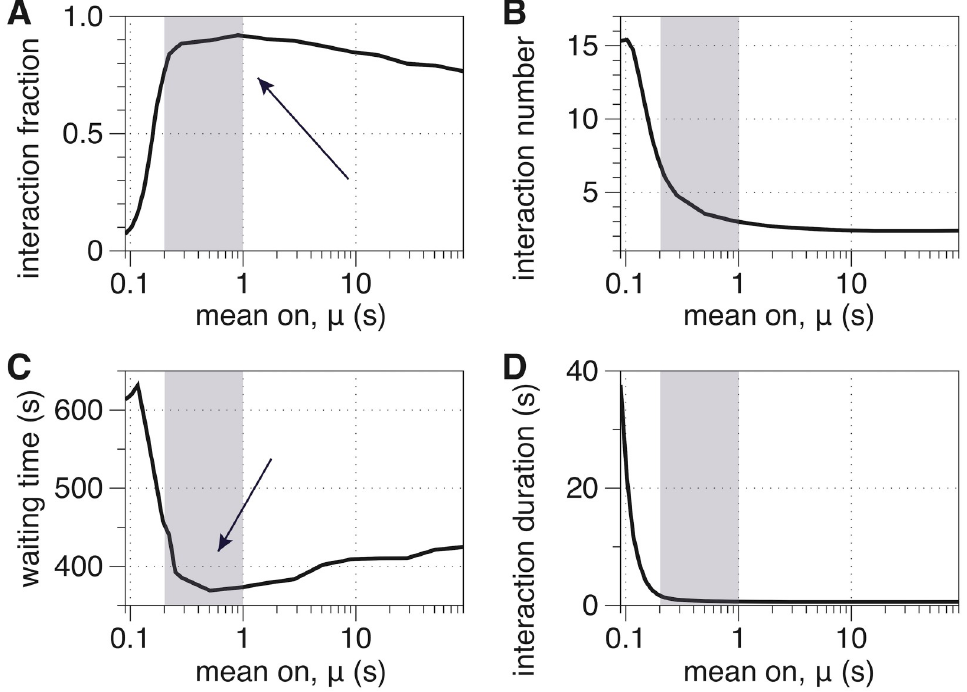
Fig 6. Mixing statistics for gene interactions: (A) mixing fraction; (B) mean interaction number; (C) mean waiting time; and (D) mean interaction duration, which we plot as versus μ . The shaded regions indicate the regime of flexible clustering, μ 2 (0.19, 1). The arrows in panels (A) and (C) highlight that the interaction fraction and mean waiting time are both optimized for this range of μ . In contrast, this regime is associated with sharp transitions for the mean interaction number and duration, which both monotonically decrease with μ